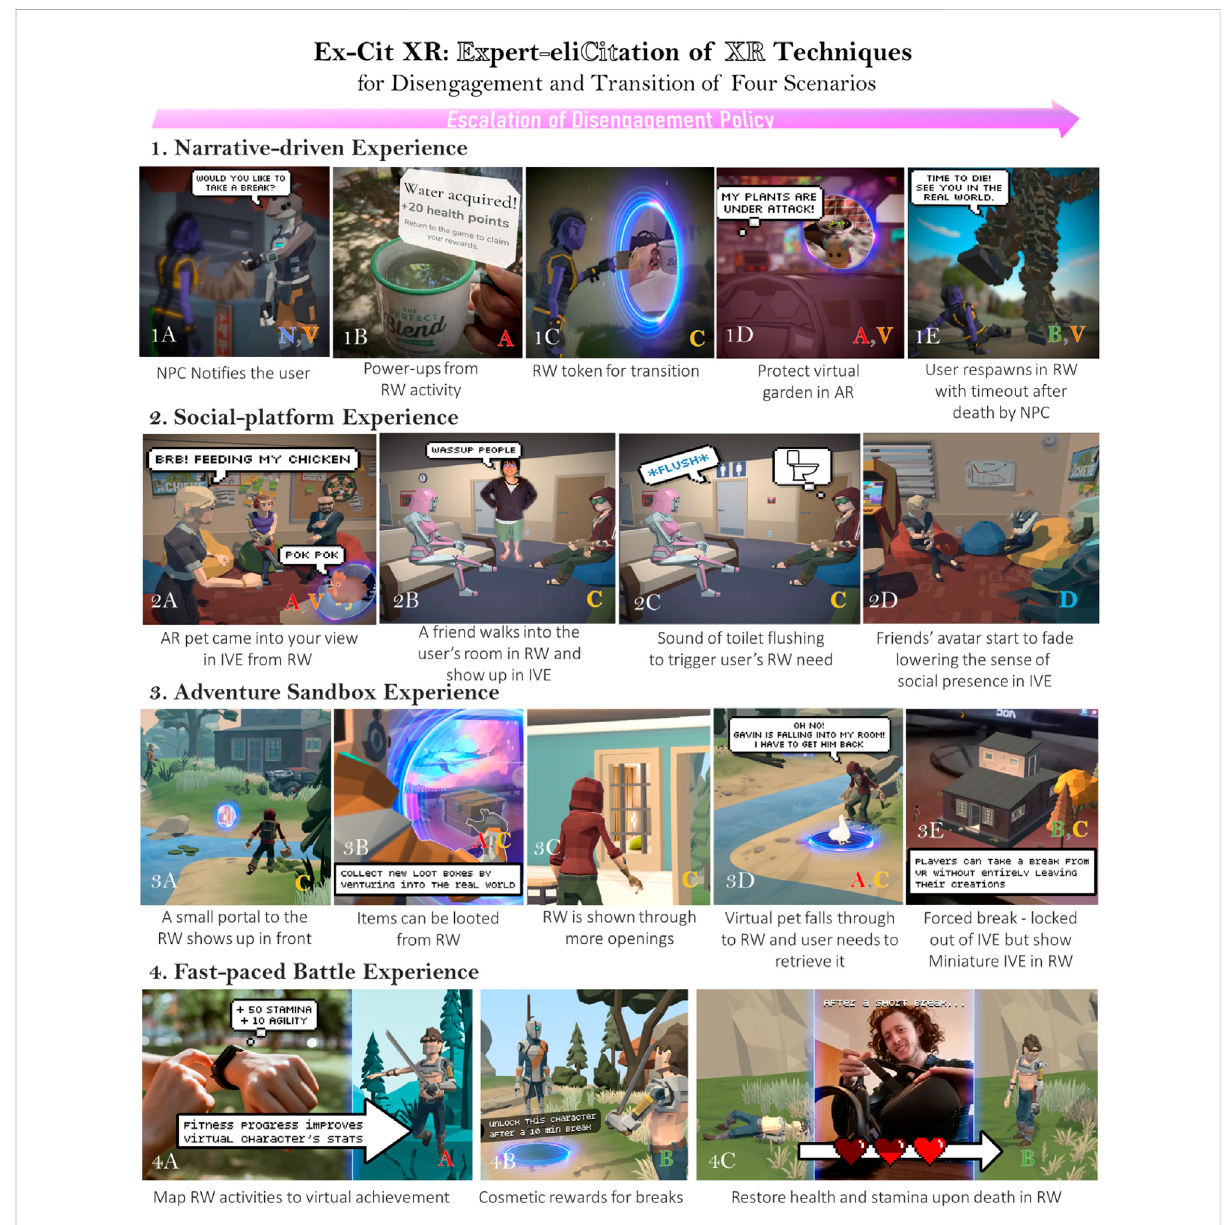
FIGURE 3 Exemplary use cases of Ex-Cit XR visualisation and interaction techniques for disengagement and transition of four unique scenarios in IVEs. Scenarios: 1-Narrative-driven experience: (1A) NPC noti fi es the user, (1B) power-ups from RW activity, (1C) RW token for transition, (1D) protect virtual garden in AR, and (1E) user respawnsin RW with timeoutafter death by NPC; 2-Social-platform experience: (2A) AR petcameinto user ’ sview in IVE from RW, (2B) a friend walks into the user ’ s room in RW and show up in IVE, (2C) Sound of toilet fl ushing to trigger user ’ s RW need, (2D) friends ’ avatar start to face lowering the sense of social presence in IVE; 3-Adventure sandbox experience: (3A) a small portal to the RW shows up in front, (3B) items can be looted from RW, (3C) RW is shown through more openings, (3D) virtual pet falls through to RW and user needs to retrieve